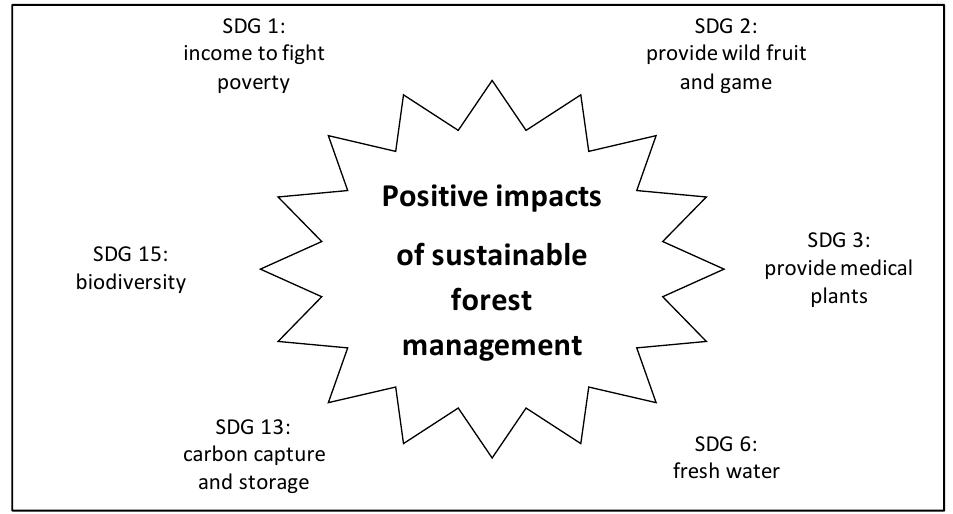
Figure 1. Positive impacts of sustainable forest management on other Sustainable Development Goals (SDGs) (based on [40]).